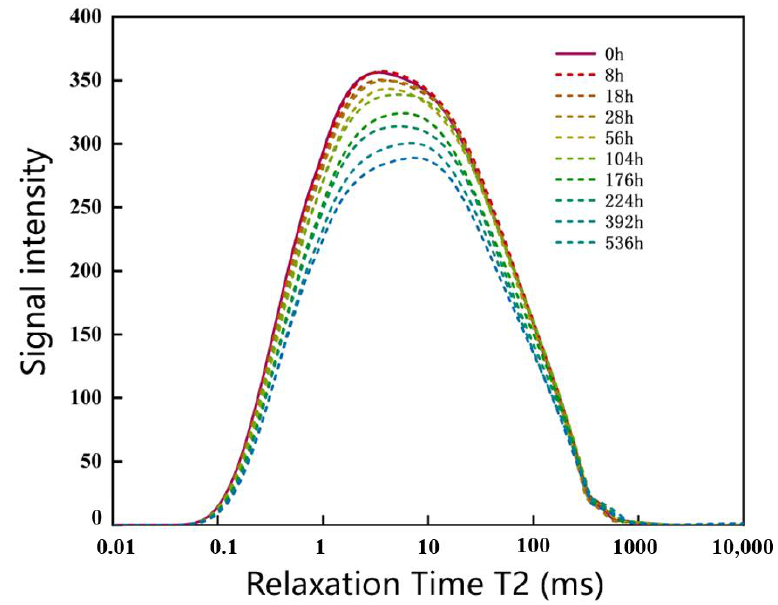
Figure 8. Development of T 2 of sample XEW at 1 atm.